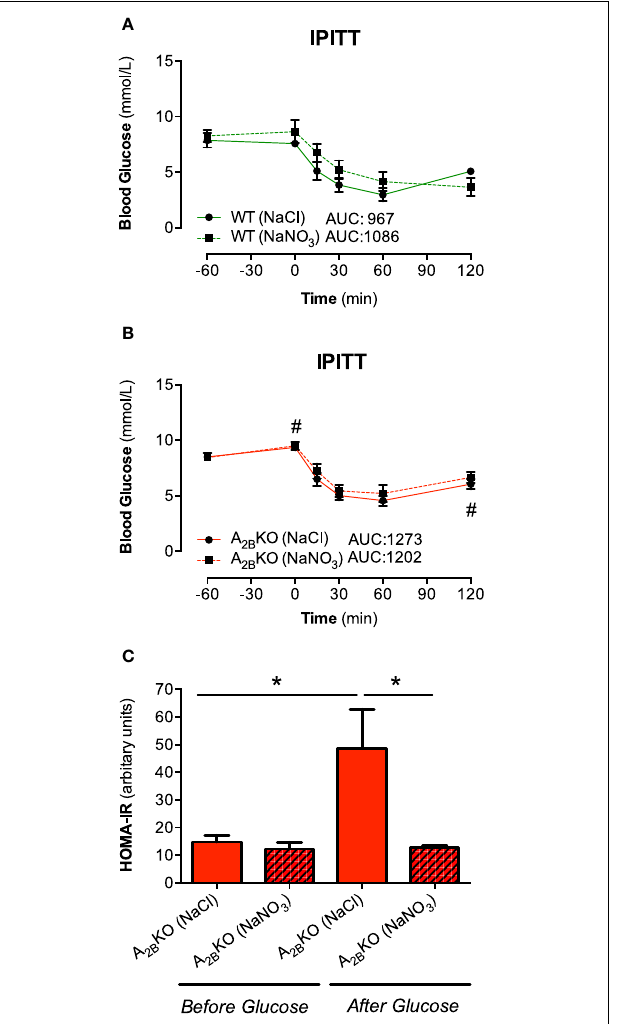
FIGURE 3 | IPITT and HOMA-IR. Plasma glucose levels in response to insulin injection were not influenced by nitrate treatment in WT (A) and A 2B KO mice (B) . HOMA-IR, a measure of insulin resistance, increased following glucose injection in A 2B KO mice, which was prevented by prior nitrate treatment (C) . Values are mean ± SEM, n = 10 –16/group. # p < 0 . 05 vs. WT; * p < 0 . 05 among the indicated groups.